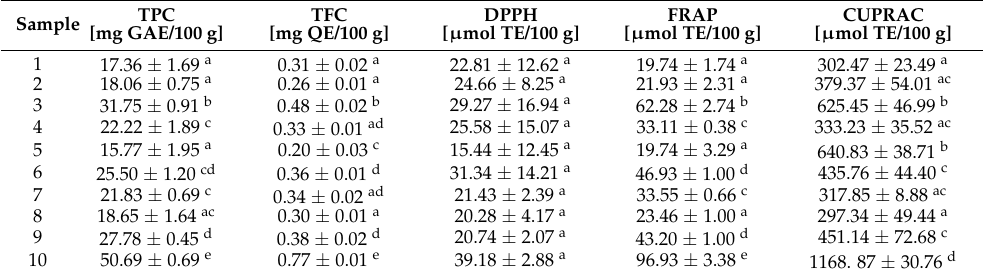
Table 2. Total phenolics and flavonoids content as well as antioxidant properties of goldenrod honeys.